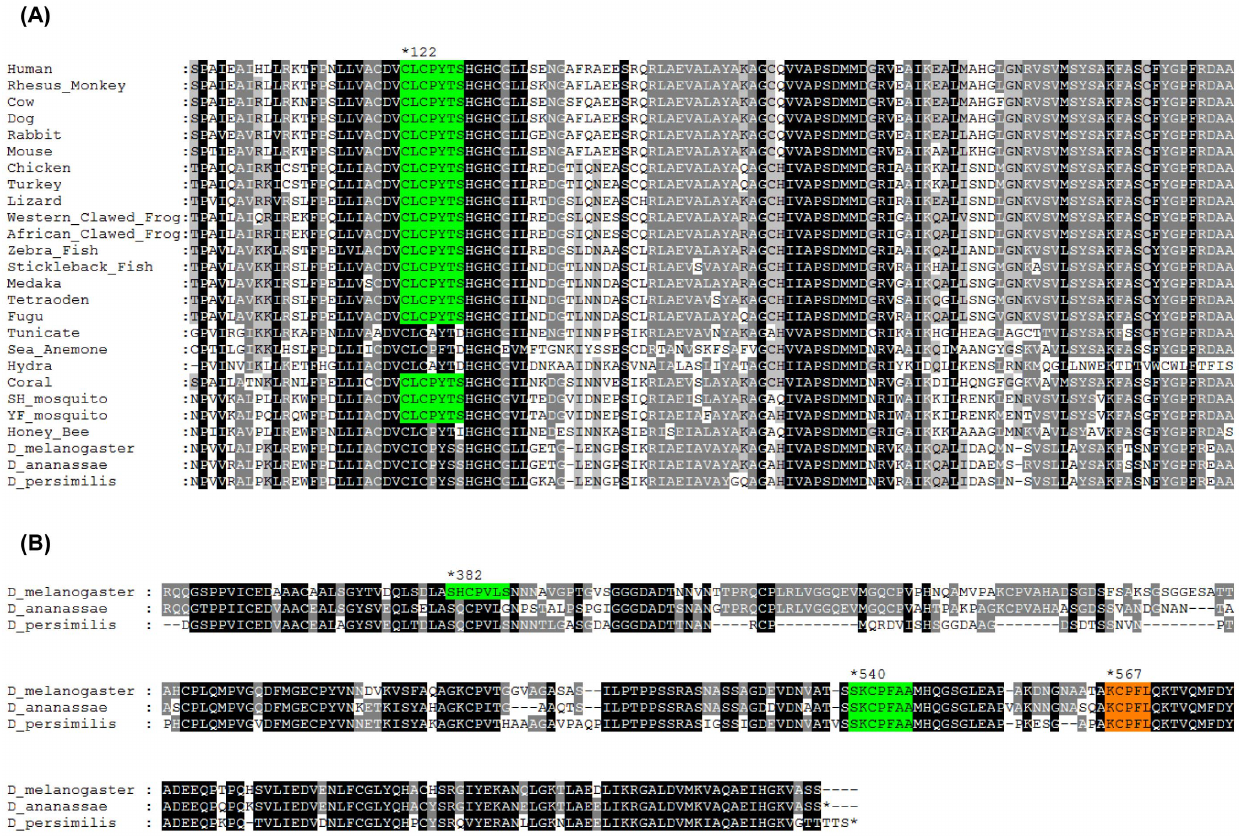
Figure 6. Heme-regulatory motifs (HRMs) in PBGS and PBGD. Multiple sequence alignments of PBGS (A) and PBGD (B) are shown, with HRM_t and HRM_r colored orange and green, respectively. Amino acid numbers for HRM_t and HRM_r are also shown according to the first protein sequence in the alignment.